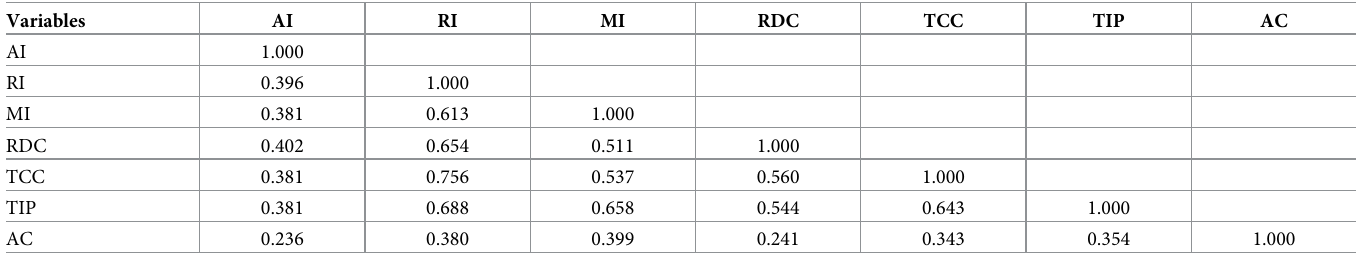
Table 2. Discriminant validity test (HTMT